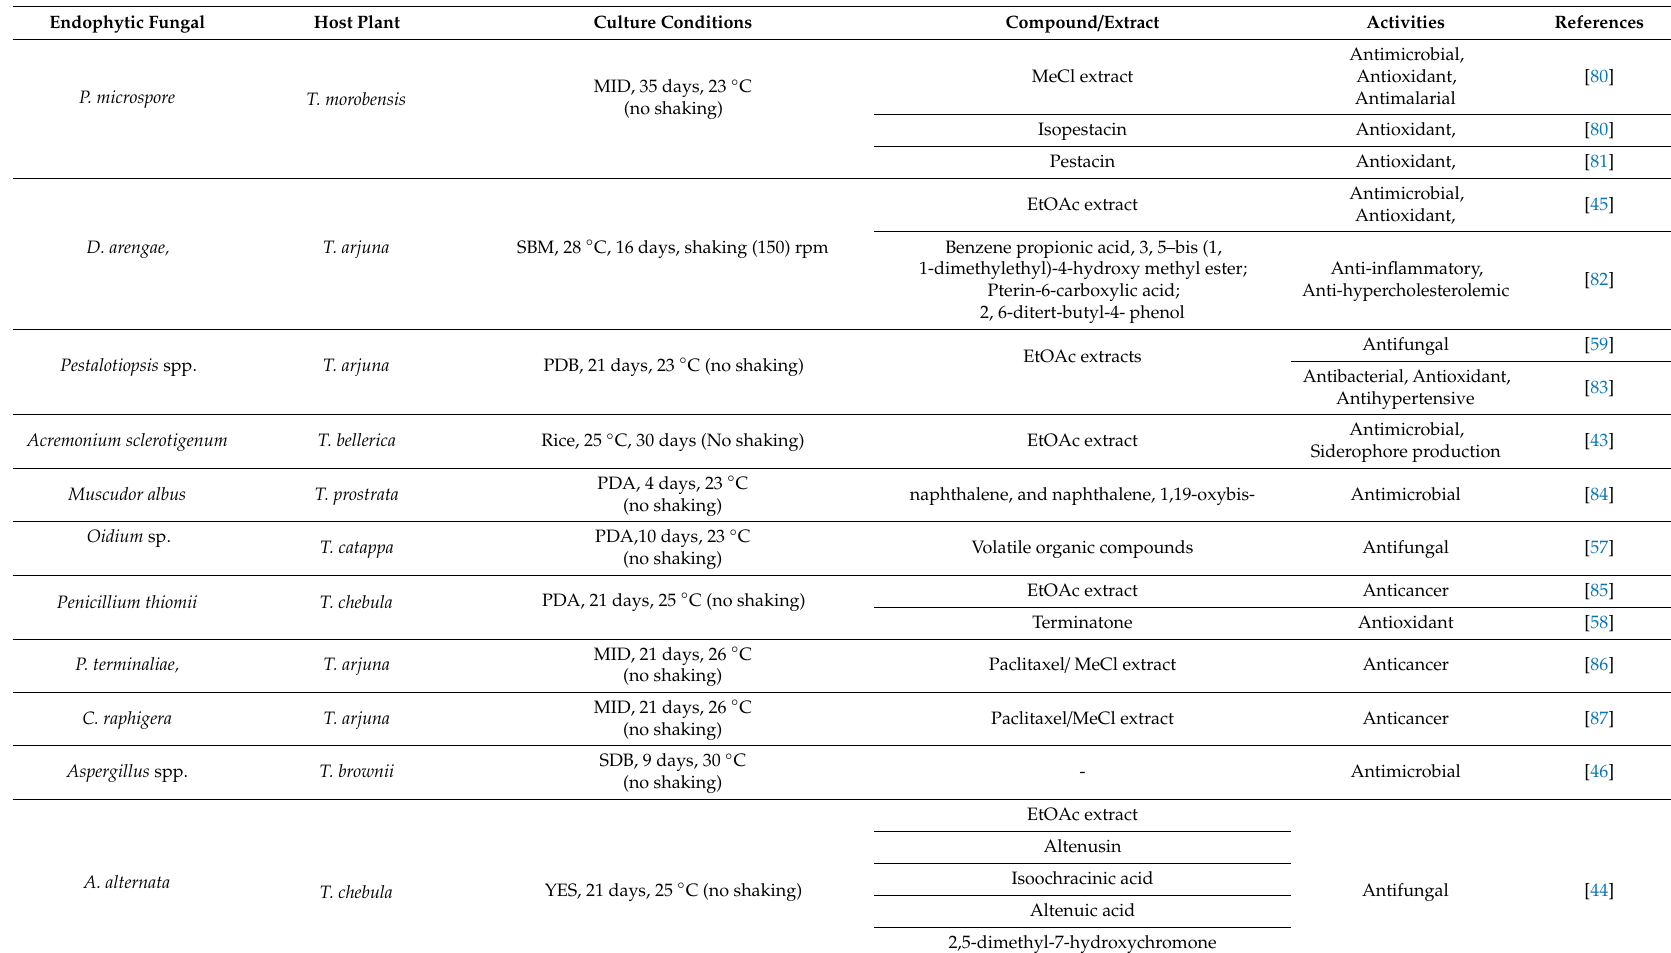
Table 2. Biological activities of fungal endophytes from di ff erent species of Terminalia